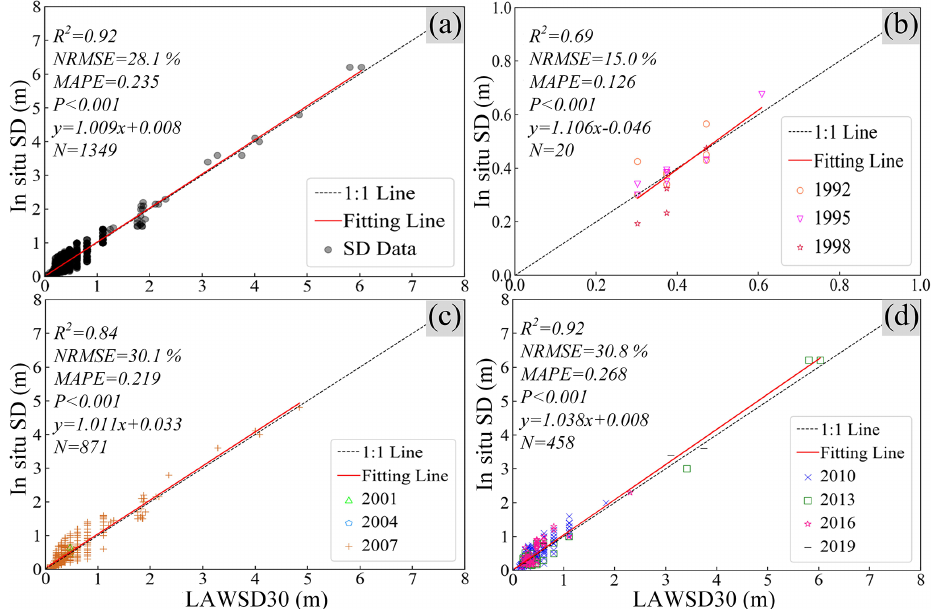
Figure 4. Scatterplots of the in situ measured SD data and our LAWSD30 dataset. (a) An overall scatterplot of our LAWSD30 dataset and all the collected in situ SD data, and (b–d) scatterplots of our LAWSD30 dataset and the corresponding in situ SD data in the 1990s (1992, 1995, and 1998), 2000s (2001, 2004, and 2007), and 2010s (2010, 2013, 2016, and 2019),